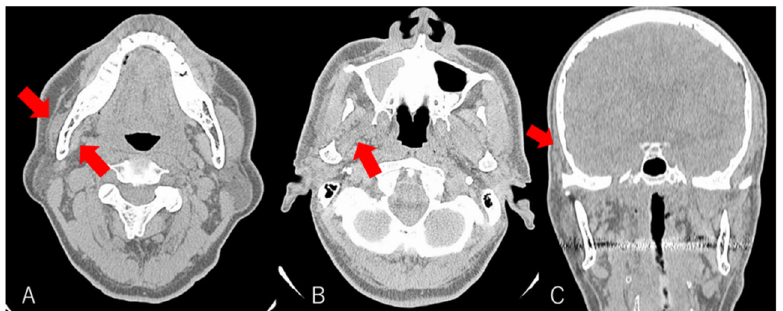
Figure 3. Axial contrast-enhanced computed tomography (CT) of the soft tissue ( A , B ) and coronal CT of the head ( C ). Atrophy of the right masseter muscle, lateral and medial pterygoid muscles, and temporalis muscle (red arrow) compared with the contralateral side.